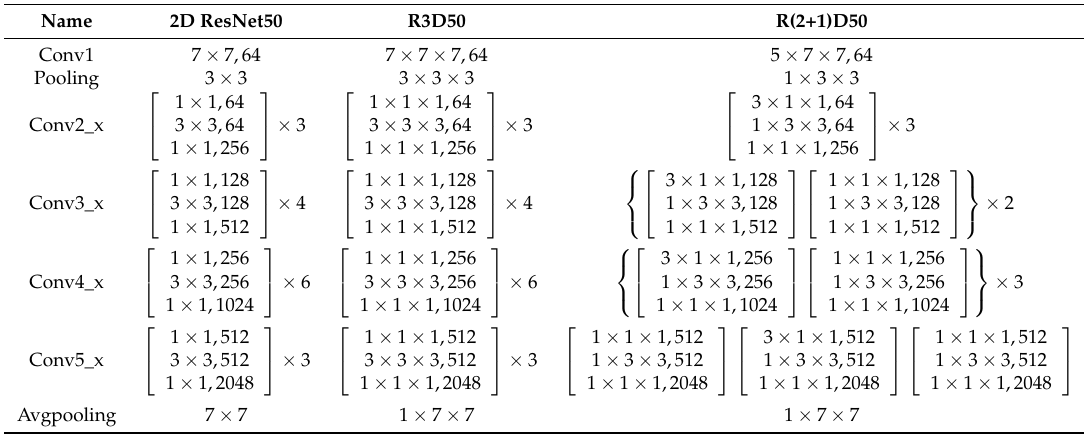
Table 1. 2D ResNet50 vs R3D50 vs